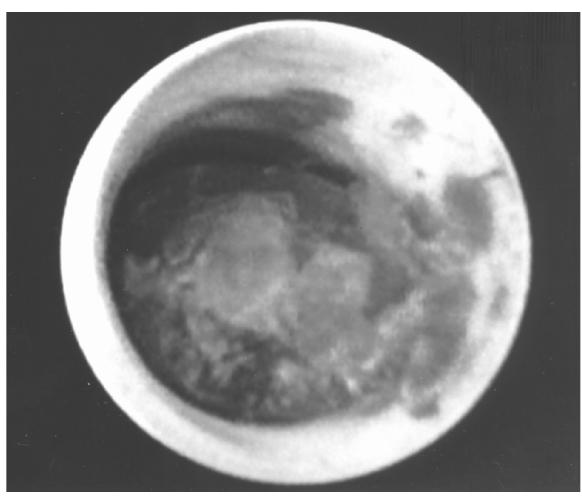
Figure 1 – Ureteroscopic image showing the ureteral lesion. Biopsy of the mass showed it to be an intrinsic endometrioma.